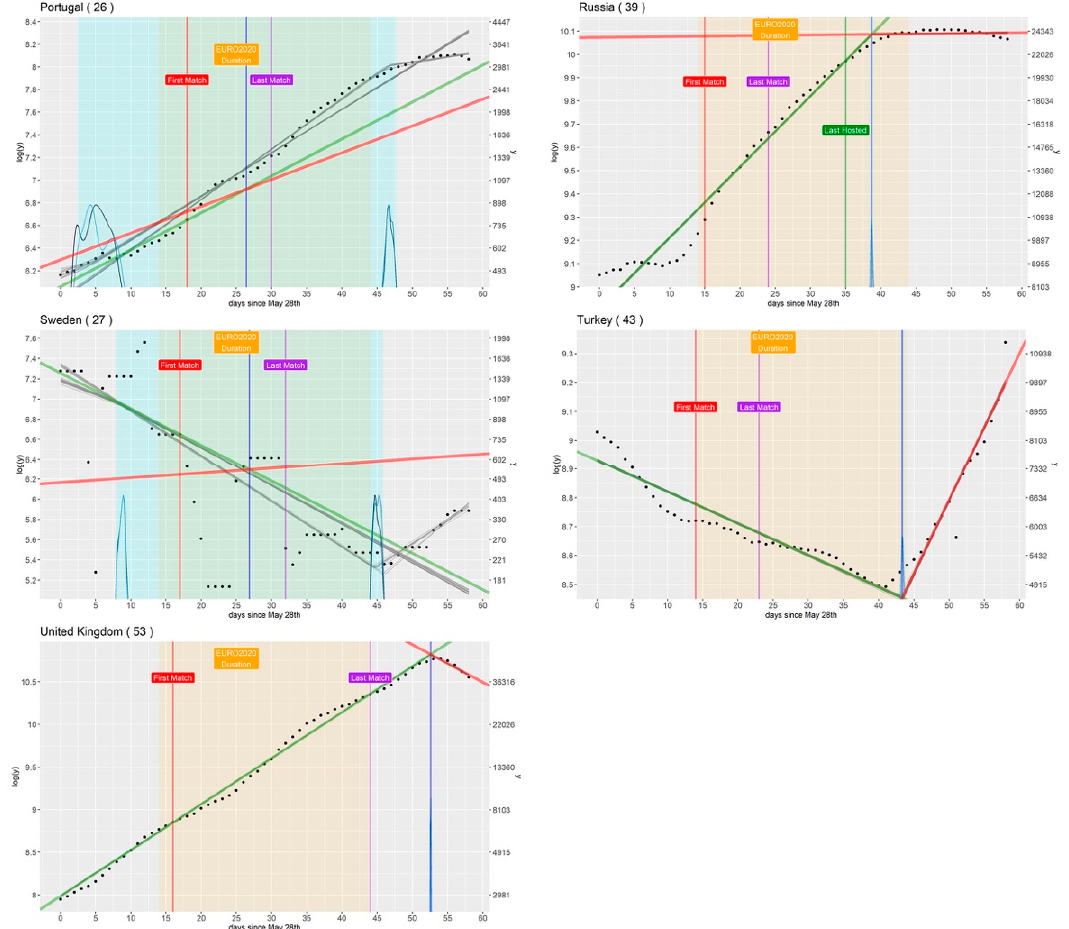
Figure 3. Portugal, Russia, Sweden, Turkey, and the UK break the pattern, without: (i) a well-recognizable changepoint and (ii) a reversal from a decrease to an increase in the SARS-COV-2 case rate, occurring not later than 2–3 weeks after the beginning of the tournament. Yellow space: duration of the tournament. Red vertical line: first match. Purple vertical line: last match. Green vertical line: last hosted match. Blue vertical line: changepoint. Blue space: CI amplitude for the changepoint. Blue bell-shaped peaks: peaks of the probability density function for the changepoint. Green segment: case rate trend before the changepoint. Red segment: case rate trend after the changepoint. Grey segments: fitted lines drawn randomly from the posterior distribution, based on the corresponding CI. Black dots: number of daily CARS-COV-2 cases. Rightmost y axis: number of cases. Leftmost y axis: logarithm of the number of